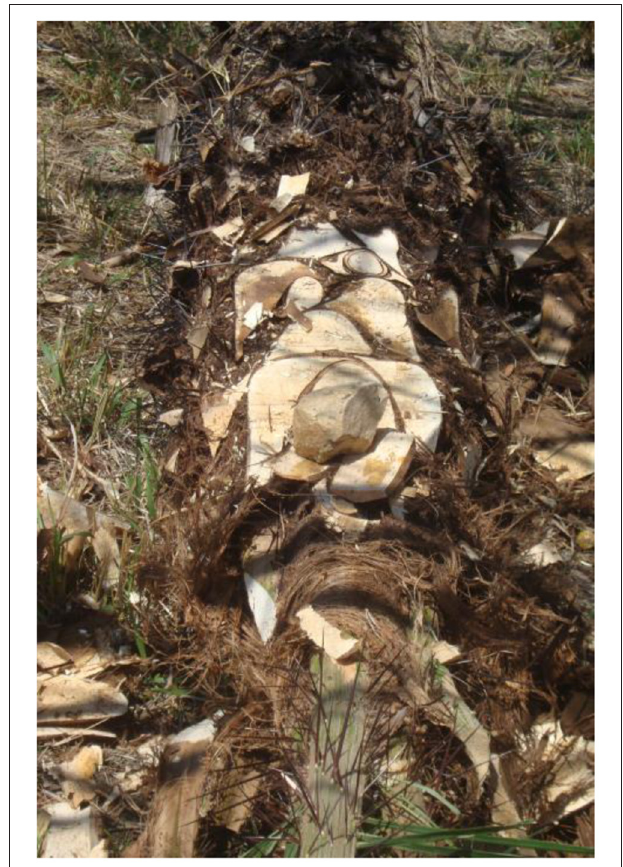
FIGURE 4 | Coyol palms once the “canoe” has been excavated and covered with a piece of wood, fastened with a